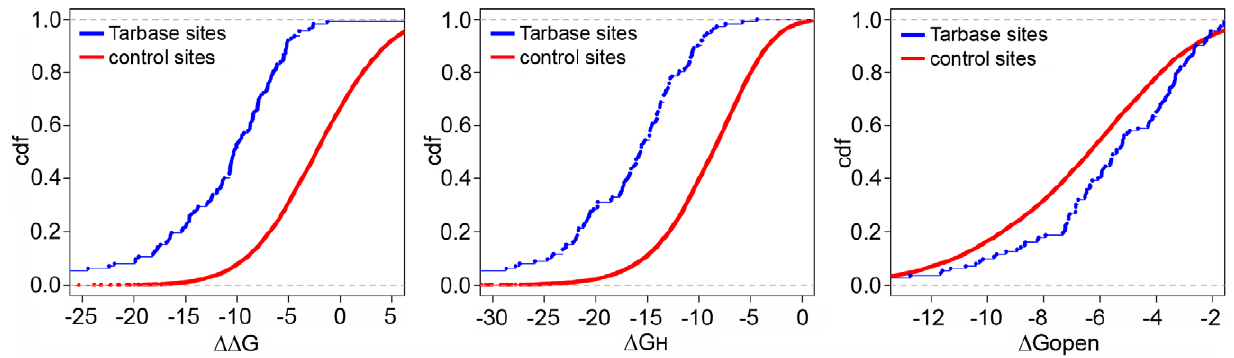
Figure 1. Cumulative density distribution of energy values at known miRNA target sites (Tarbase) vs. control sites. All energy values are in kcal/mol unit. (A) DD G. (B) D G H . (C) D G open .